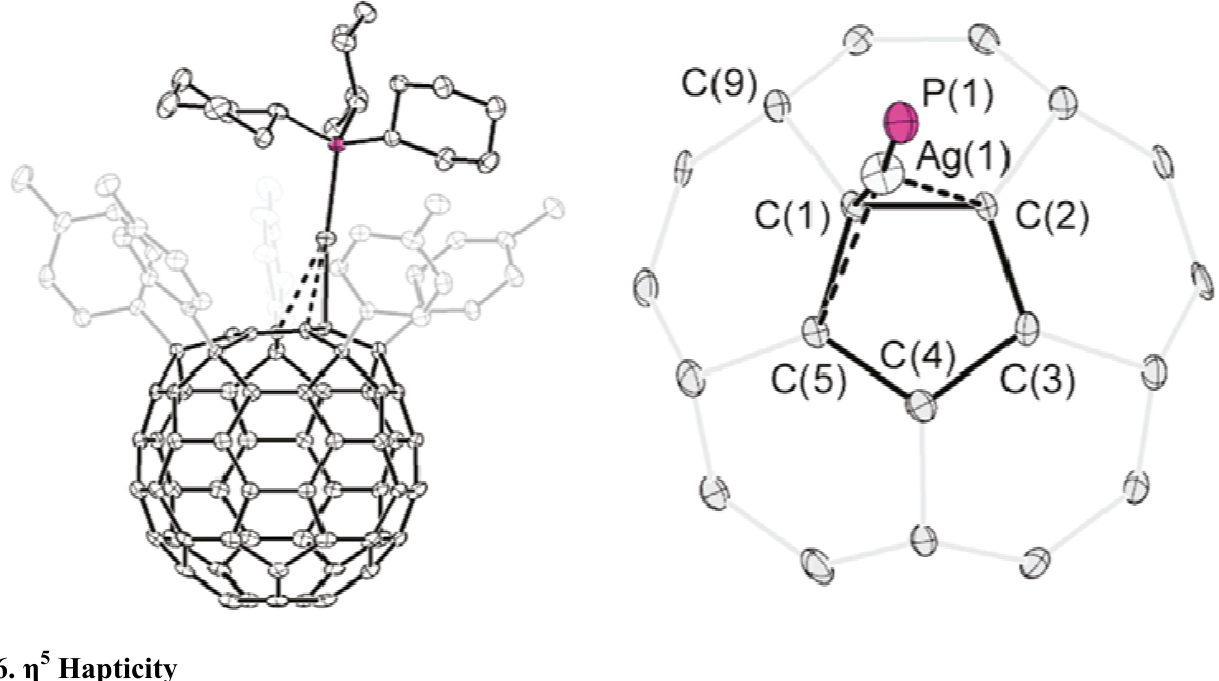
Figure 9. Rubin’s proposition of η 3 hapticity for a silver complex (Reproduced from [39] with